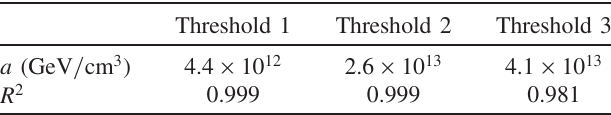
TABLE VII. Fit parameters for the curves in Fig. 22.